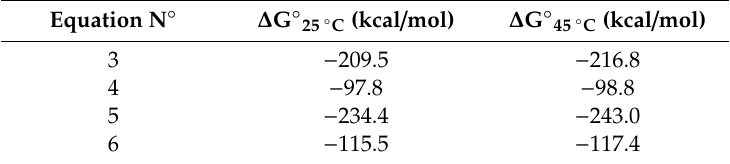
Table 8. Standard Gibbs energy values at 25 and 45 °C of proposed chemical reactions for the pretreatment stage. Equation N ◦